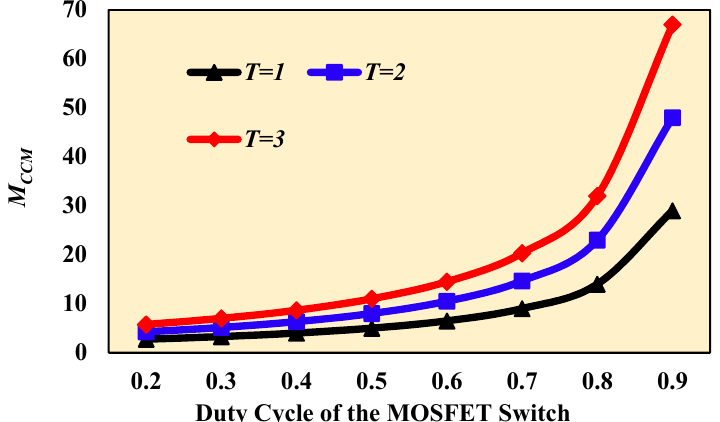
Figure 6. Voltage gain of the proposed converter for various turn ratios.